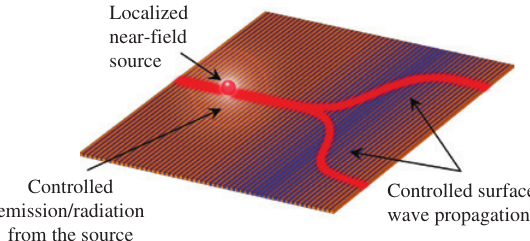
Figure 1: Illustration of an engineered metasurface illuminated by a source in the